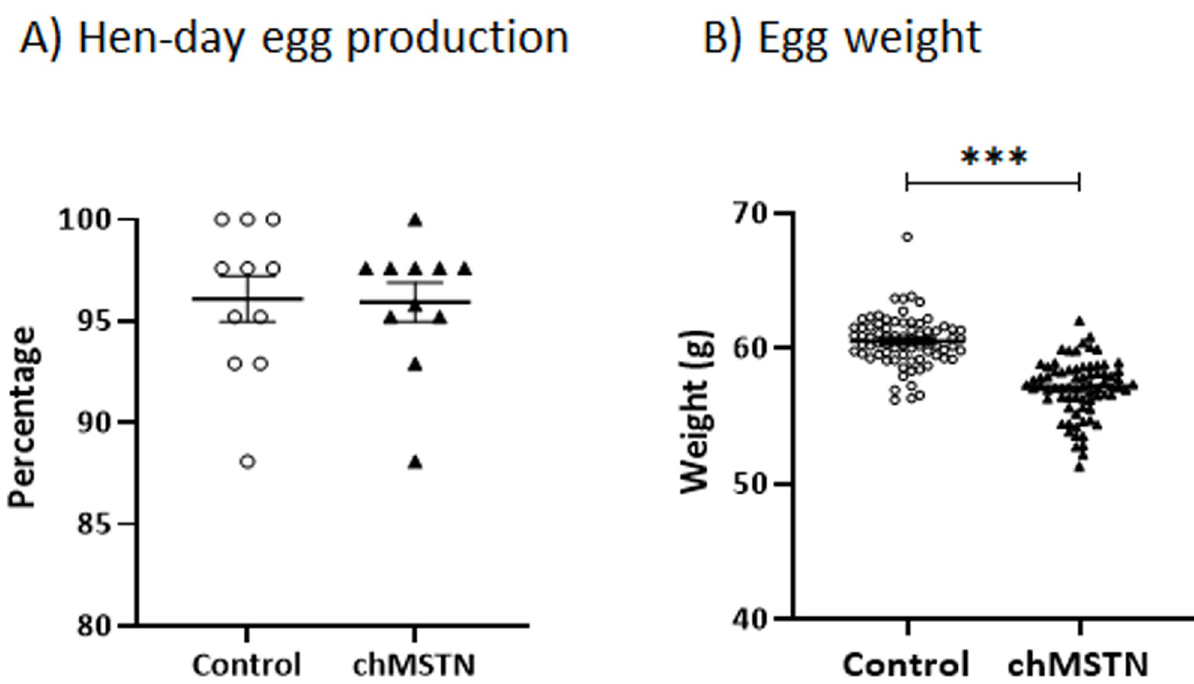
Fig 7. Hen-day egg production (A) and egg weights (B) in Experiment 1. Hen-day egg production was calculated by dividing the number of eggs produced within a week period by the average number of hens for the same time interval during the 11 weeks. Data were analyzed by one-way ANOVA. ��� , P < 0.001.